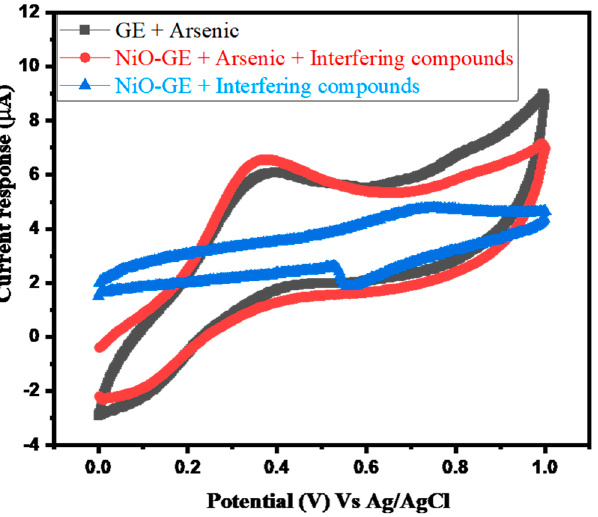
Figure 8. CV response of NiO-GE for 5 ppb As 3+ only (black) and 5 ppb As 3+ + 30 ppb interferences (Cd 2+ , Hg 2+ , Cu 2+ , Zn 2+ , Mg 2+ , and Pb 2+ ) (0.1 M PBS of pH = 6) at scan rate = 50 mVs − 1 (red). CV response of NiO-GE for 0 ppb As 3+ + 30 ppb interferences (Cd 2+ , Hg 2+ , Cu 2+ , Zn 2+ , Mg 2+ , and Pb 2+ ) (0.1 M PBS of pH = 6) at scan rate = 50 mVs − 1 (blue).